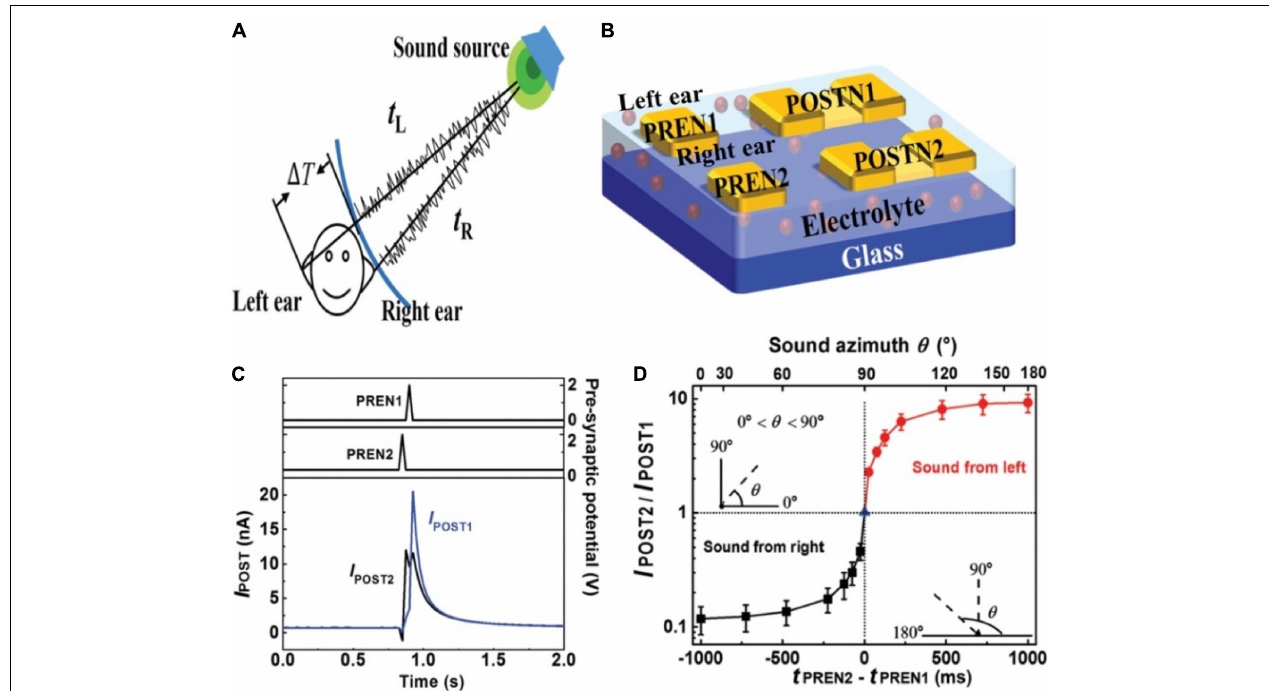
FIGURE 12 | (A) Schematic diagram of sound location by binaural effect in human brain. (B) Sound location in artificial neural network based on the transistor. (C) Postsynaptic currents of POSTN2 and POSTN1 when sound comes from right direction. (D) I POST 2 /I POST 1 changes with time interval and sound azimuth (adapted from He et al., 2019).